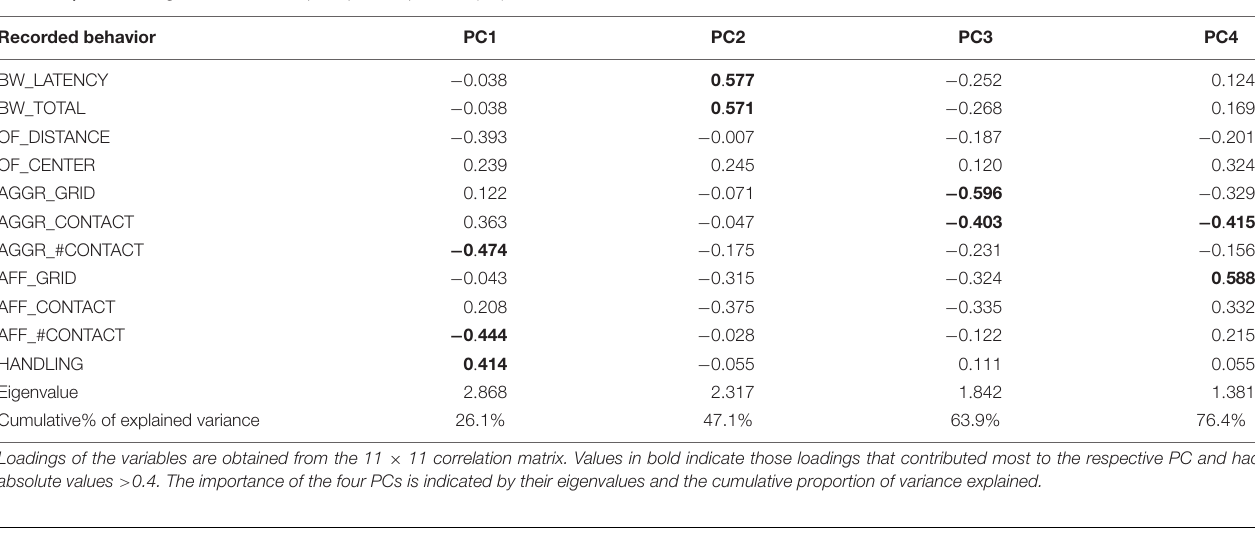
TABLE 2 | PCA loadings for the first four principal components (PC) of recorded behaviors.